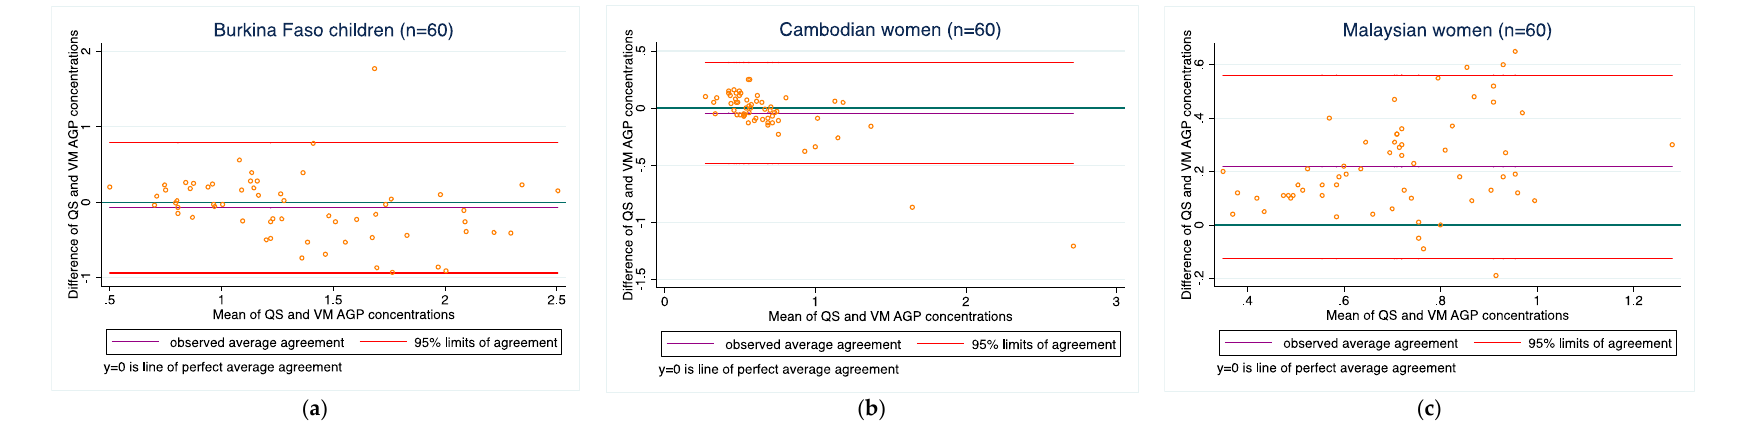
Figure 3. AGP concentrations for ( a ) Burkina Faso children ( n = 60); ( b ) Cambodian women ( n = 60); and ( c ) Malaysian women ( n = 60).